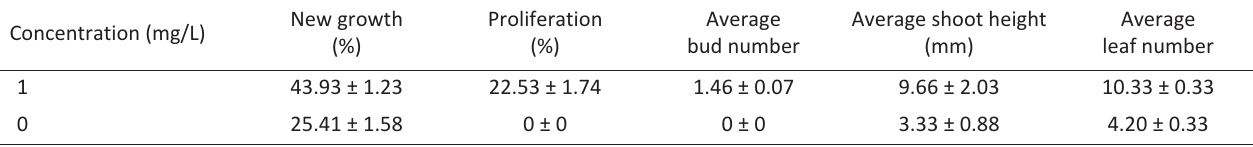
Values are mean ± standard error.